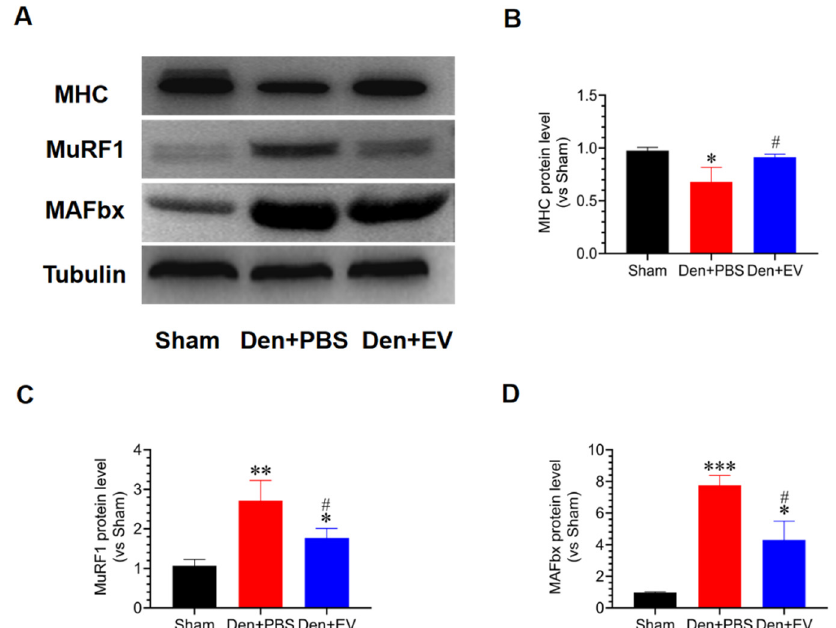
Figure 9. SKP-SC-EVs inhibit ubiquitinated proteolysis during denervated muscle atrophy. ( A ) Rep- resentative western blot detection of MHC, MuRF1, and MAFbx in different treatment groups. ( B – D ) Histogram showing the relative abundances of MHC, MuRF1, and MAFbx in the tibialis anterior muscle after denervation. n = 3, * p < 0.05, ** p < 0.01, and *** p < 0.001 vs. Sham group; # p < 0.05 vs. Den + PBS group. The sham group was injected with PBS; the Den group was injected with PBS containing SKP-SC-EVs (5 × 10 10 particles) (Den + EV group), and; the control PBS group (Den + PBS group) was injected with PBS. The tibialis anterior muscle samples were collected 14 days after treatment. Den, denervation; EVs, extracellular vesicles; IL, interleukin; SCs, Schwann cells; SKP, skin-derived precursors; TNF- α , tumor necrosis factor- α .